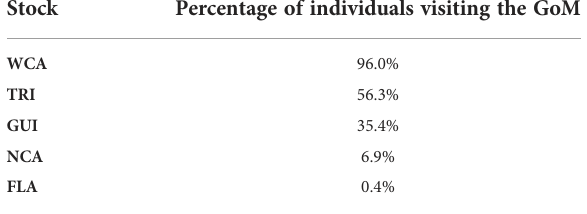
TABLE 3 Percentages of individuals visiting the GoM in each stock. TABLE 2 Distribution of the simulated individuals in the four